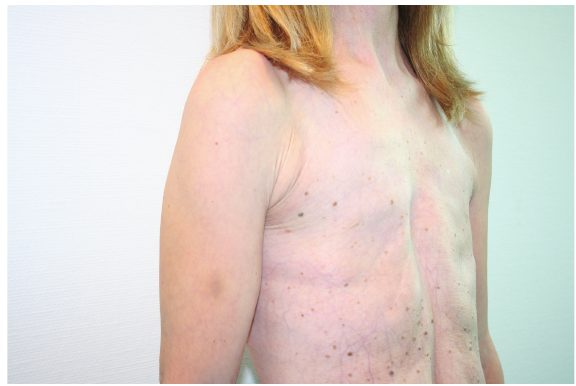
Figure 3: Preoperative oblique view.